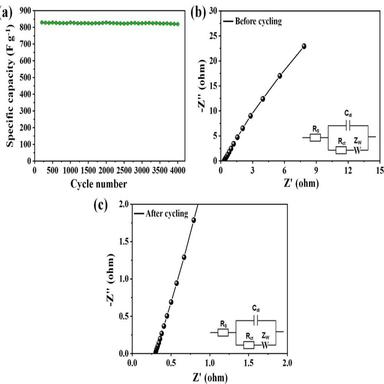
(a) Cycling stability plot, and EIS plot showing a high frequency region of the Mn-Co Oxides electrode material (b) before and (c) after different cycling tests and inset shows the Equivalent circuit to fit the Nyquist plots.